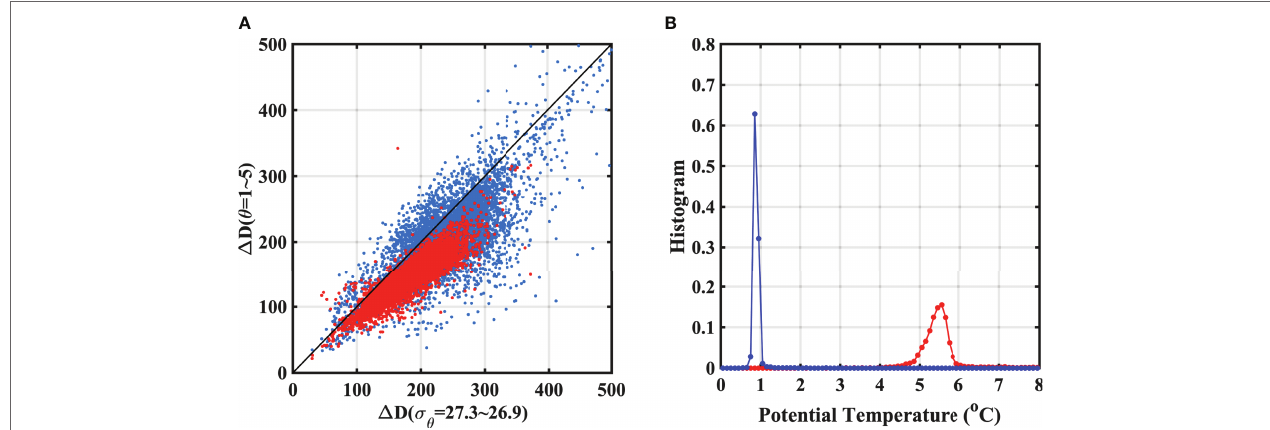
) and temperature-based (1°C −5°C) thickness obtained from Argo data. Red dots represent FIGURE 2 | (A) Scatter plot between the density-based (26.9−27.3 σ θ the data within the area denoted using dashed line in Figure 1B , and blue dots represent data from the whole East Sea. (B) Histograms of temperatures on the isopycnal surfaces of 26.9 and 27.3 σ shown in red and blue lines, respectively, which are computed from the Argo data obtained from the area of dashed line in θ Figure 1B